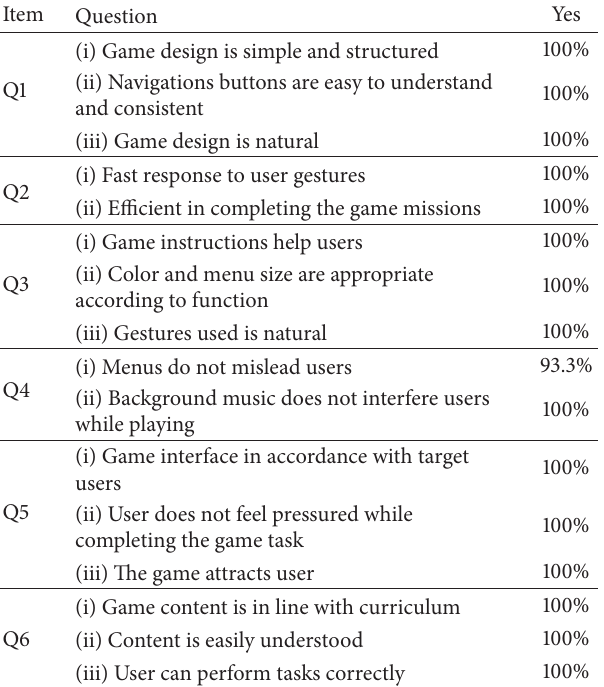
Table 3: The result of the observation